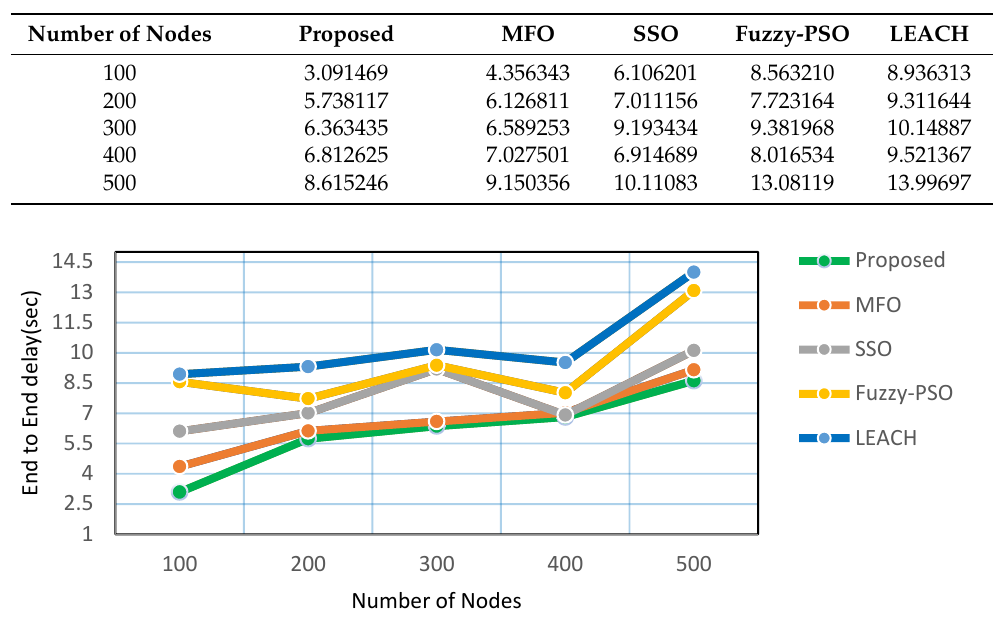
Table 6. Comparison of latency with various routing protocols.